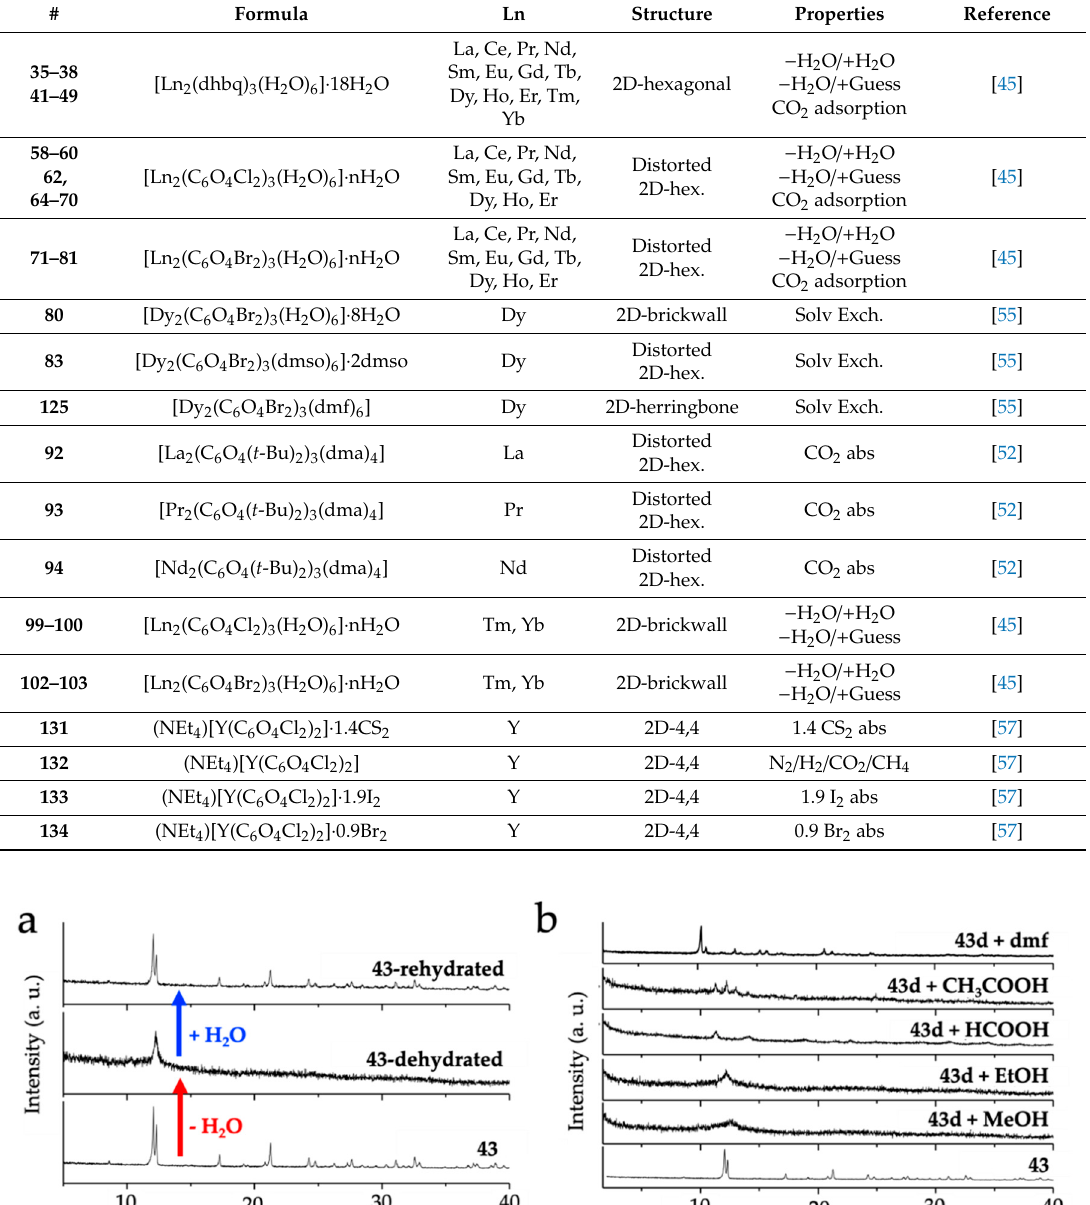
Table 30. Ln ‐ anilato compounds with gas/solvent adsorption or solvent exchange capacity.